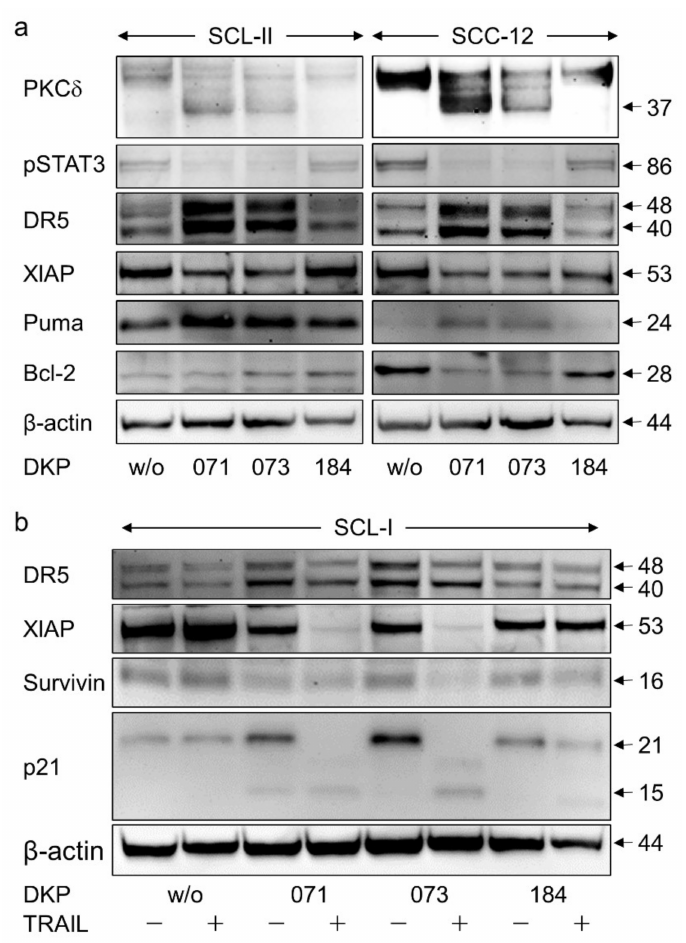
Figure 5. Expression of apoptosis agonists. ( a ) Cell lines SCL-II and SCC-12 were treated for 24 h with indirubins (DKP-071, -073 and -184; 10 µ M). ( b ) Cell line SCL-I was treated for 24 h with indirubins (DKP-071, -073 and -184, 10 µ M) ± TRAIL (50 ng/mL). ( a , b ) Expression of PKC δ (fragment 37